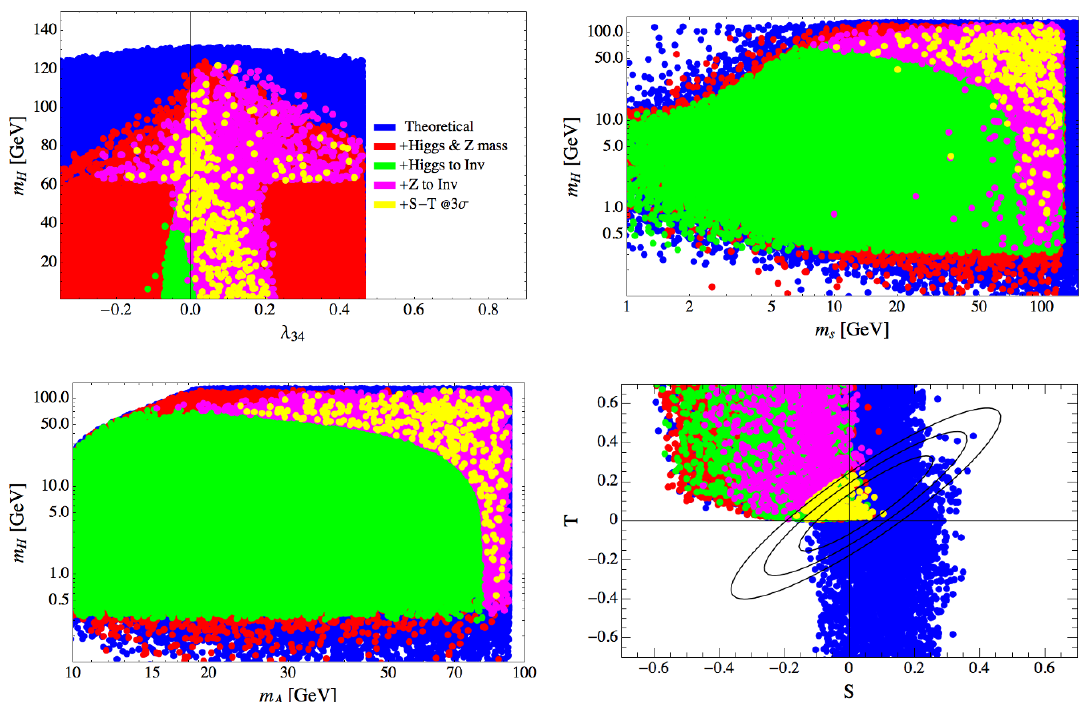
Figure 1 . E(cid:11)ect of the theoretical and experimental constraints on the parameter space of the (cid:23) 2HDSM. We show in blue the points allowed by the theoretical constraints (eqs. (3.1){(3.2)) and m > 80 GeV, in red those that also give the correct values for m h and m Z , in green points that in H (cid:6) addition are allowed by h ! invisible, in magenta those that also pass the limits on the Z invisible width and (cid:12)nally in yellow those within them that are compatible with S; T and U at 3 (cid:27) . Top left: ( (cid:21) 34 ; m H ). Top right: ( m s ; m H ). Bottom left: ( m A ; m H ). Bottom right: ( S; T